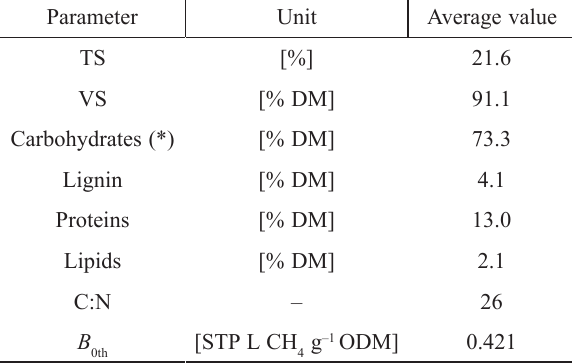
Table 4 – Blend characteristics